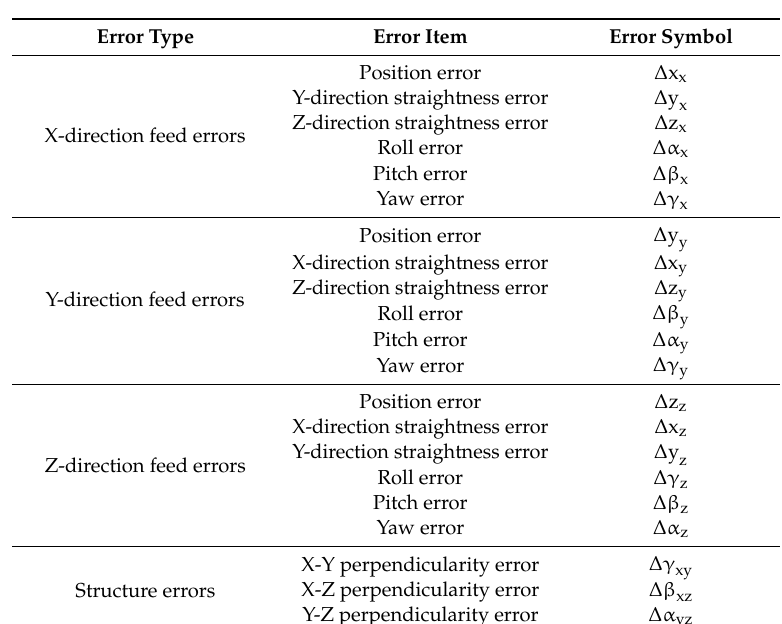
Figure 3. Error measurement. ( a ) Principle of the position error measurement; ( b ) Principle of the straightness error measurement; ( c ) Position error measurement experiment; ( d ) Straightness error measurement experiment. Table 3. Geometric errors in the chosen caving and milling